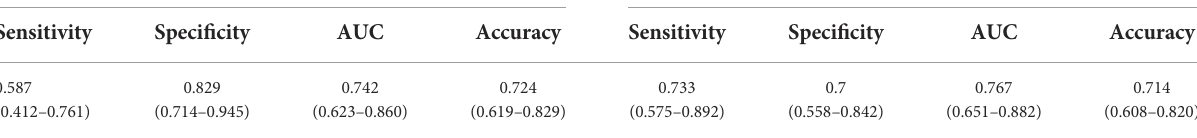
TABLE 3 The summary of the radiomics model performance.